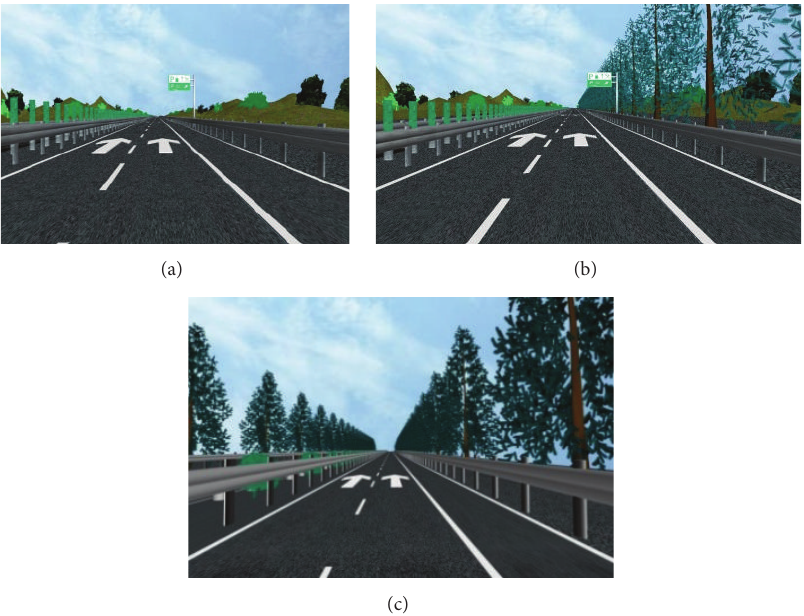
Figure 3: Typical simulated landscape patterns. (a) Open. (b) Semiopen. (c)